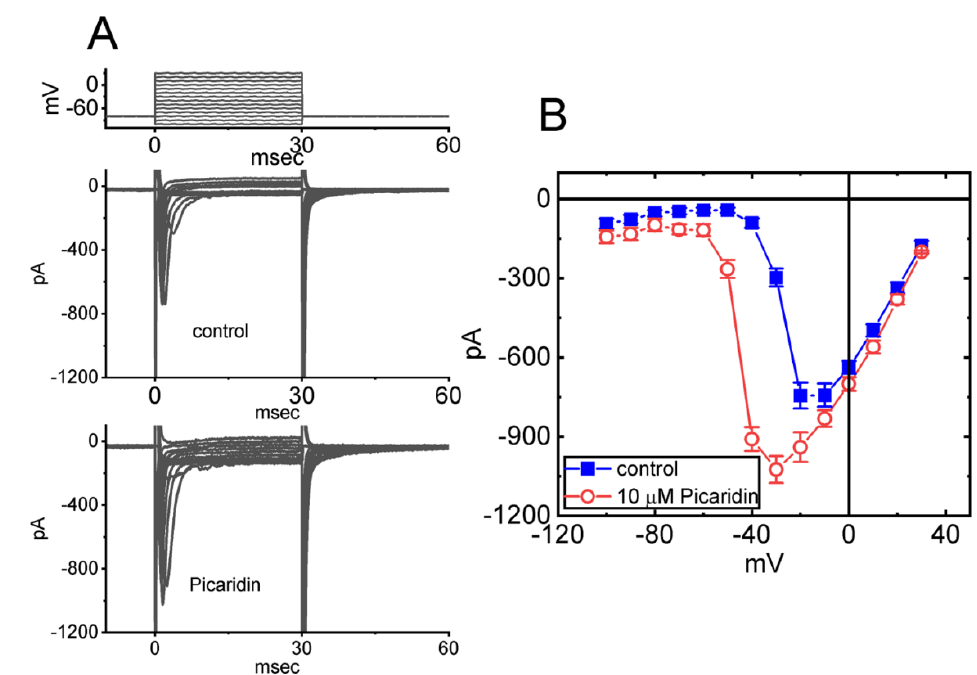
Figure 2. Mean current versus voltage (I–V) relationship of I Na(T) caused by picaridin. Current amplitude (i.e., I Na(T) ) was taken at the start of each abrupt depolarization. ( A ) Exemplar current traces achieved in the control period (upper) and during cell exposure to 10 µ M picaridin (lower). The voltage-clamp protocol imposed is shown in the uppermost part. ( B ) Steady-state I – V relationship of I Na(T) without (blue filled squares) and with (red open circles) cell exposure to 10 μM picaridin (mean ± SEM; n = 8 for each point). Note that cell exposure to picaridin depressed the amplitude of I Na (T) ; moreover, the overall steady-state I – V relationship of the current was shifted to more negative potentials in its presence.